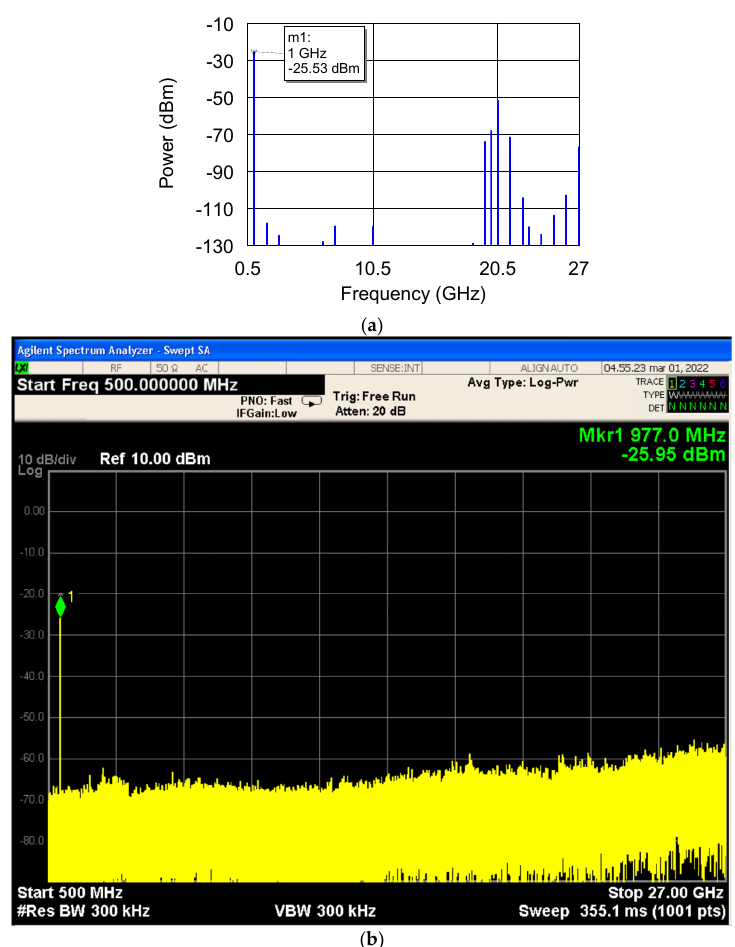
Figure 9. ( a ) Simulated and ( b ) measured frequency spectrum at the output of the receiver for an input signal with a center frequency and power equal to 2 GHz and − 30 dBm, respectively. The measured down ‐ converter conversion gain confirms the expected behavior over the entire frequency bandwidth. It was extracted by injecting input tones ranging from 2 GHz to 18 GHz, with an input power of − 30 dBm. The conversion gain is reported in Fig ‐ ure 10.